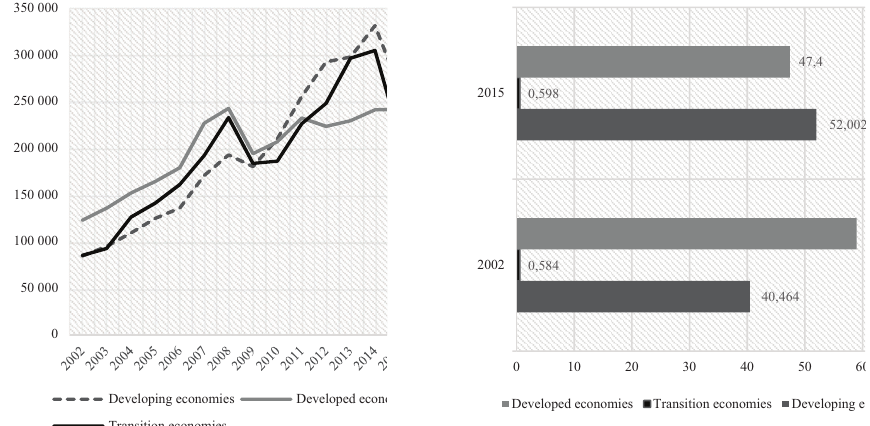
Figure 1. Export of creative goods by economic group, 2002–2015: a – values, b – shares, % (source: created by authors (based on United Nations Conference on Trade and Development STAT, 2018)